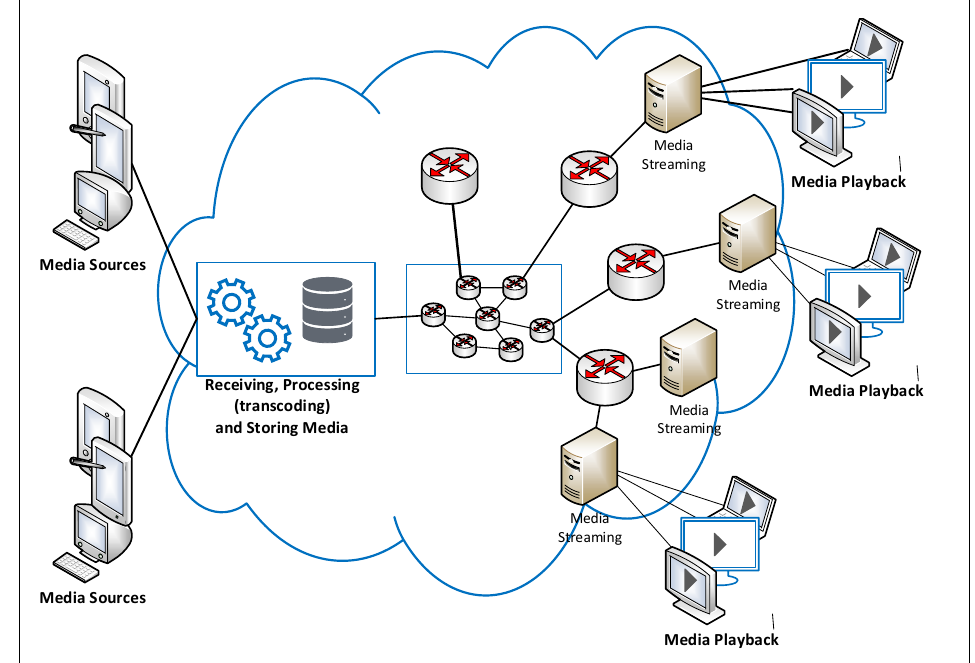
Figure 1. Cloud-Based Video Streaming